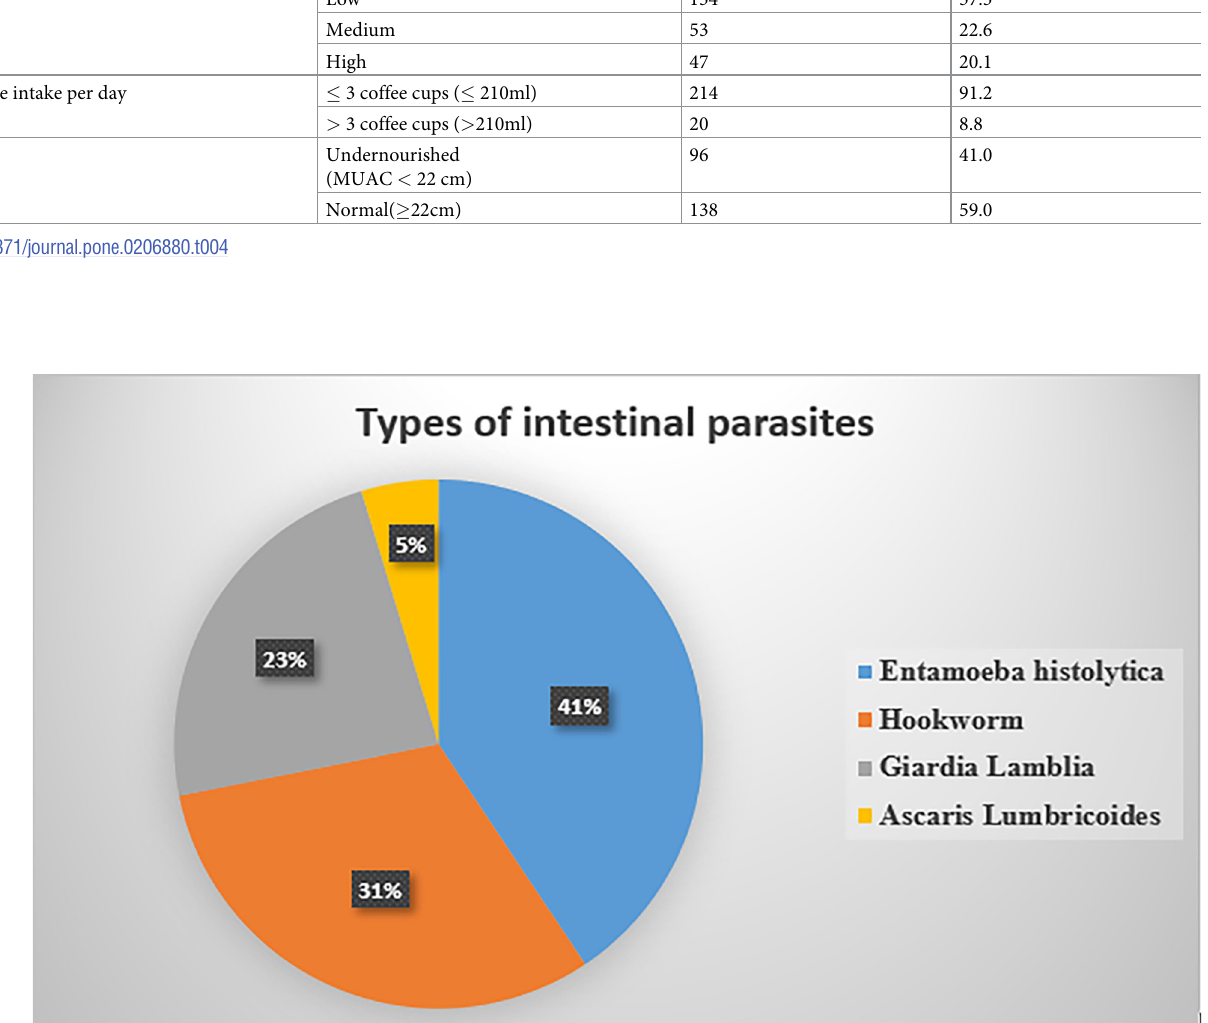
PLOS ONE | https://doi.org/10.1371/journal.pone.0206880 November8,